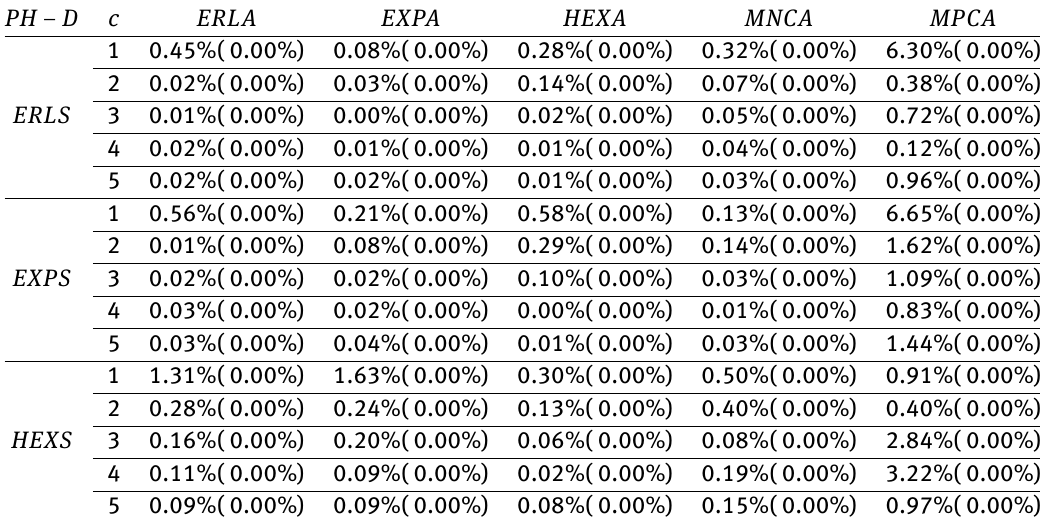
Table 2: Error percentages for E ( L )( E ( C )) under various scenarios for FEC